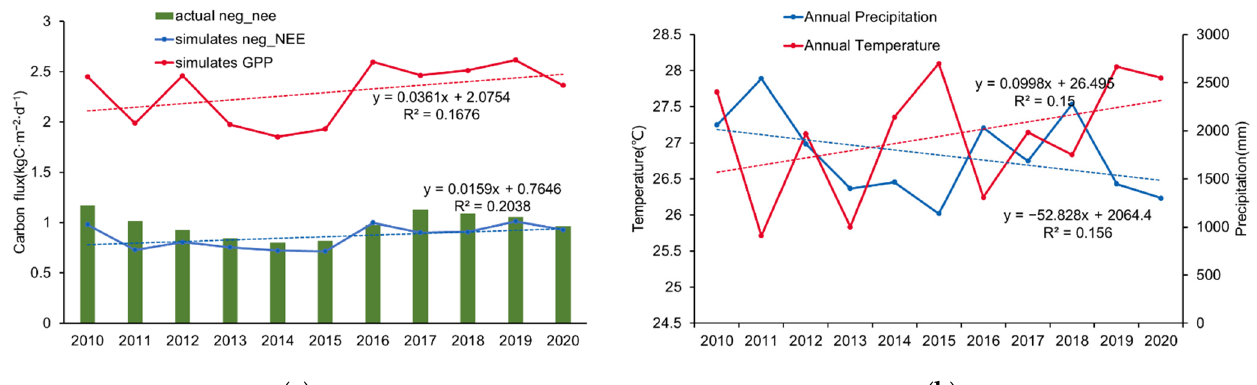
Figure 5. ( a ) Interannual GPP, NEE, and ( b ) meteorological data statistics in the study area